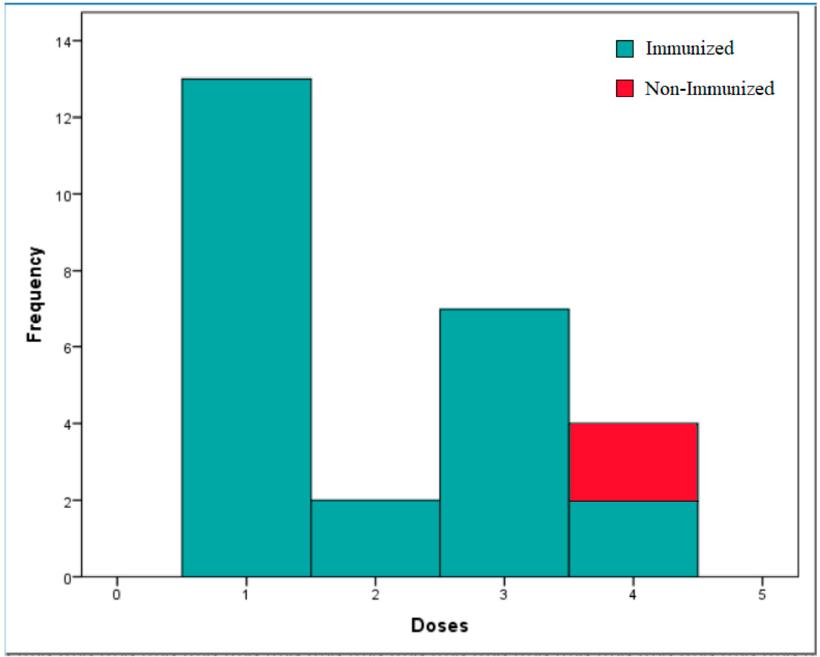
Figure 1. Immune status according to the doses of Fendrix ® administered. This histogram shows the immune response of health personnel according to the doses of Fendrix ® vaccine inoculated ( n =